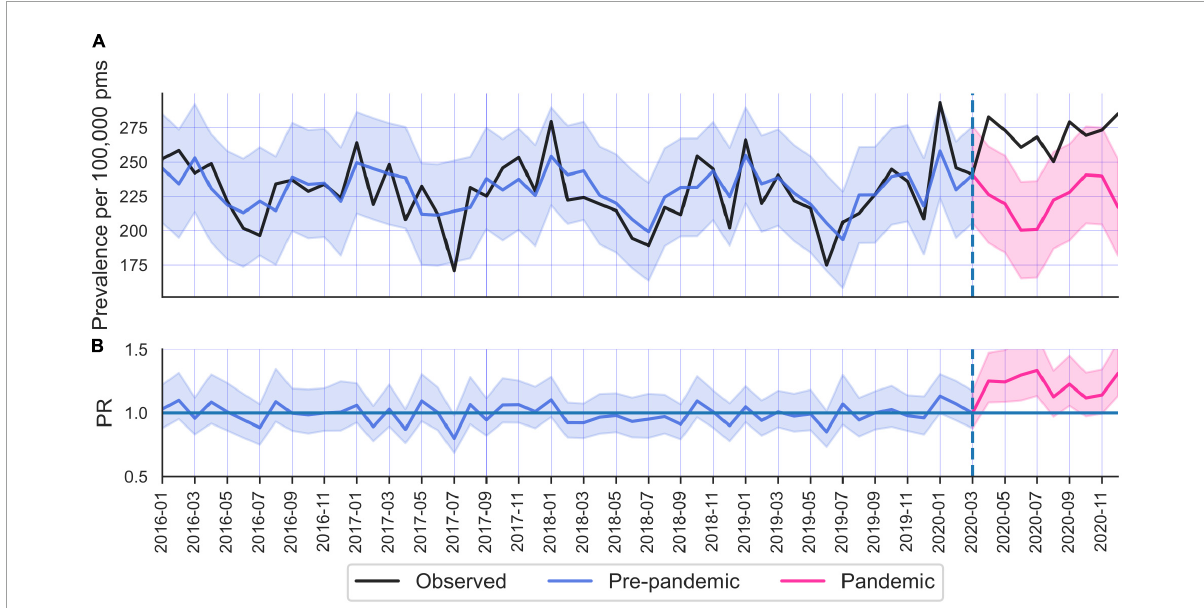
FIGURE4 (A) Common mental disorders (CMD) care prevalence in Latvia. (B) Prevalence